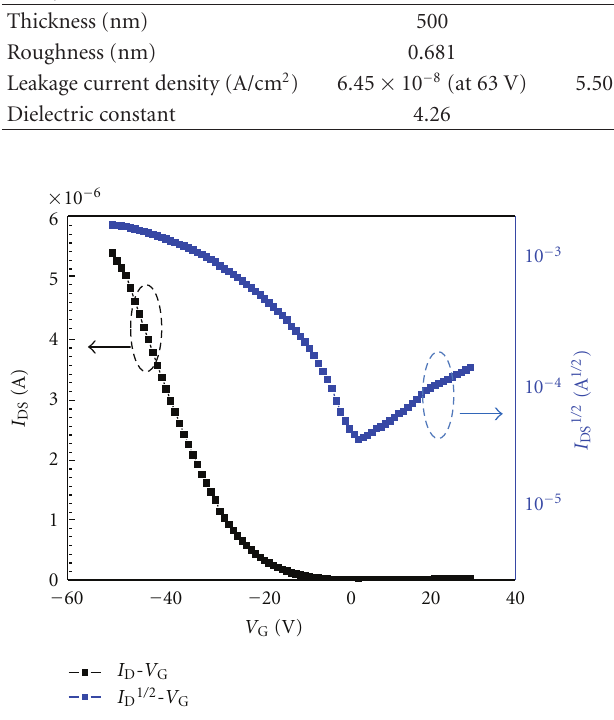
Figure 4: Transfer characteristics in saturation region for pentacene TFTs deposited on the PVP-TiO 2 nanocomposite gate dielectric insulator with 3wt% of TiO 2 contents ( V D = − 50 V).